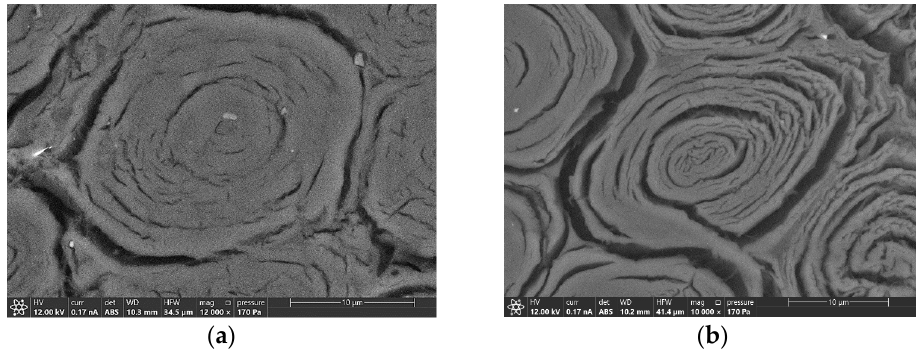
Figure 12. Backscattered electrons ESEM micrograph of a fiber of an unaged sample ( a ) and a UV (192 h) aged specimen ( b ), both taken from the external part of a vascular bundle of the central part of the culm wall.